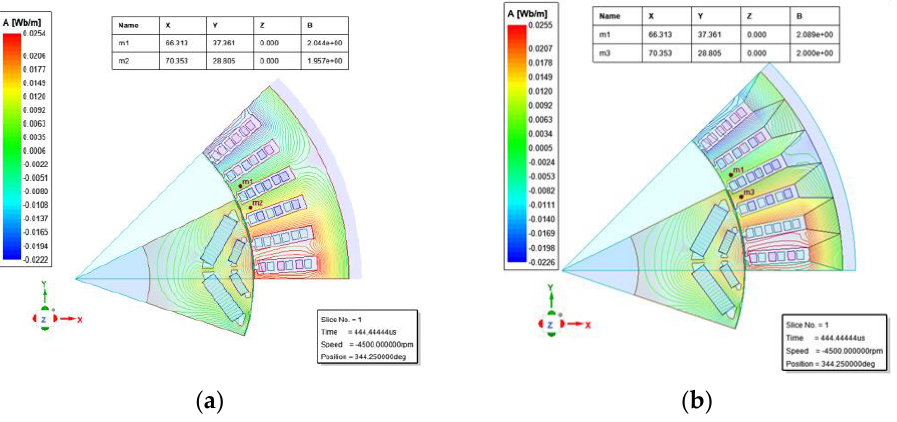
Figure 12. Electrical machine finite element simulation model. ( a ) Traditional electrical machine modeling reference model (NGO-IPM) ( b ) multi-angle spliced grain-oriented silicon steel electrical machine model (GO-IPM).